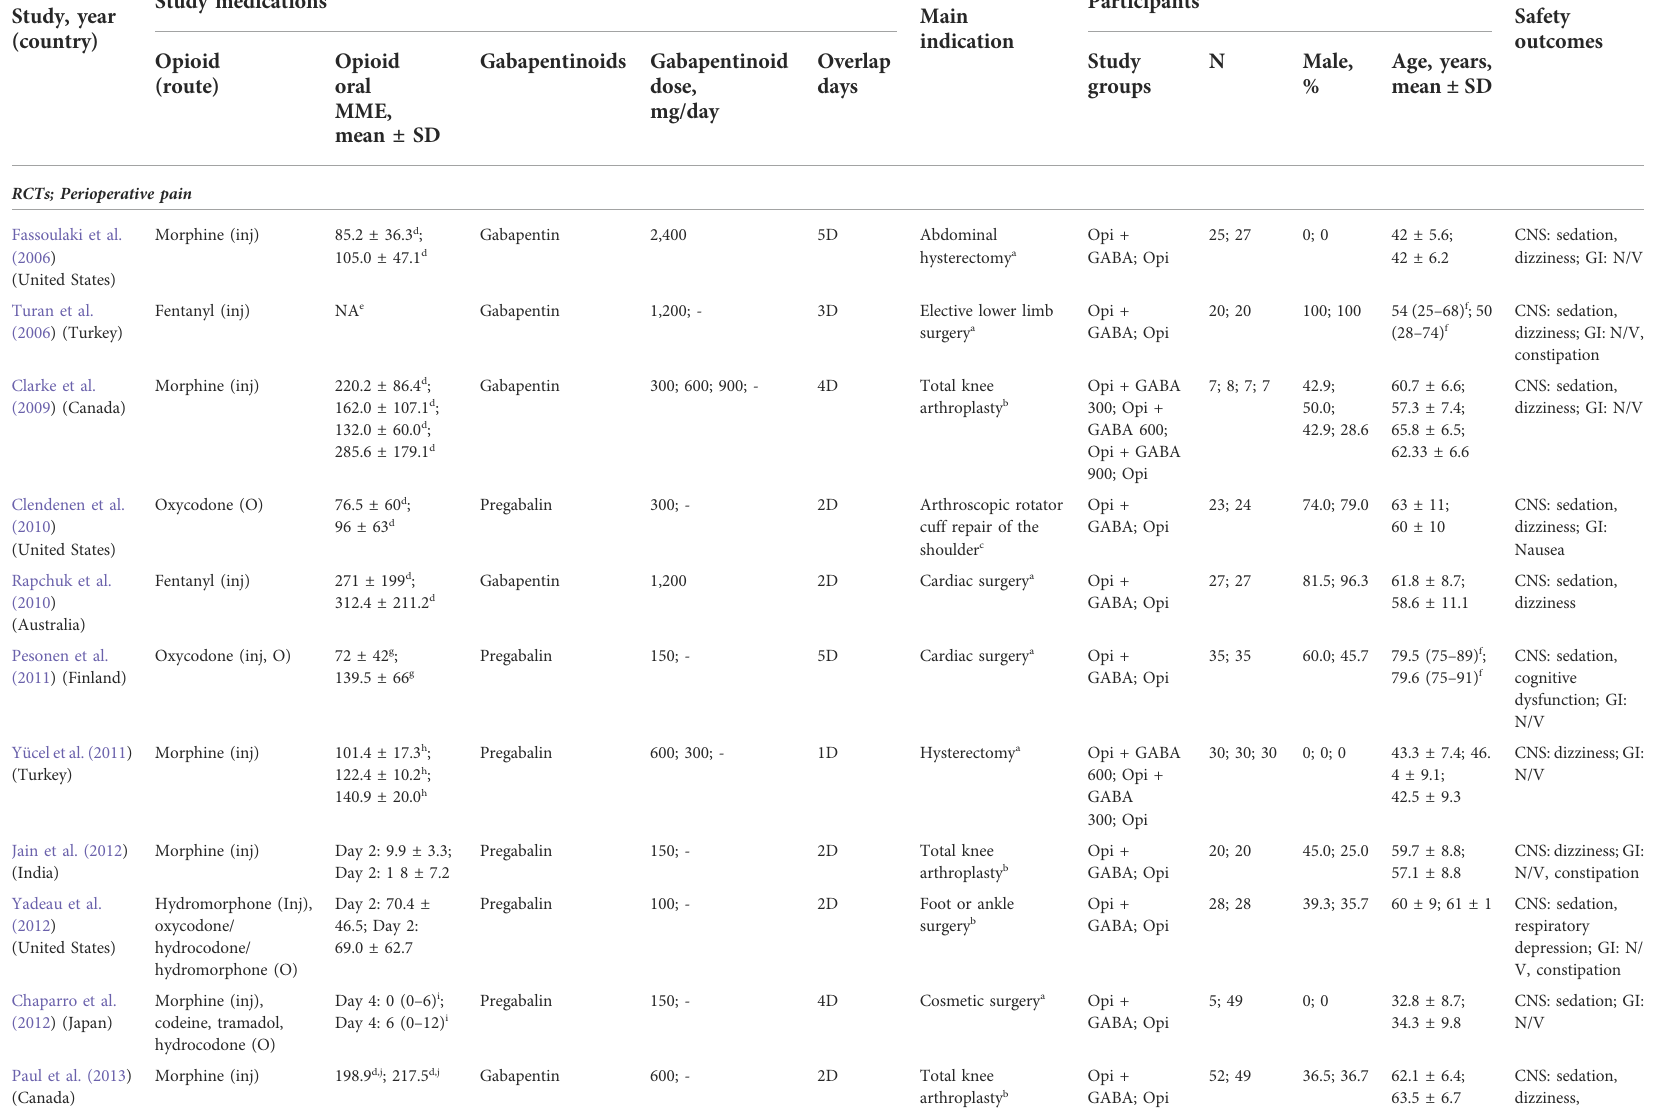
TABLE 1 Characteristics of studies reporting the risk of central nervous system depression and gastrointestinal